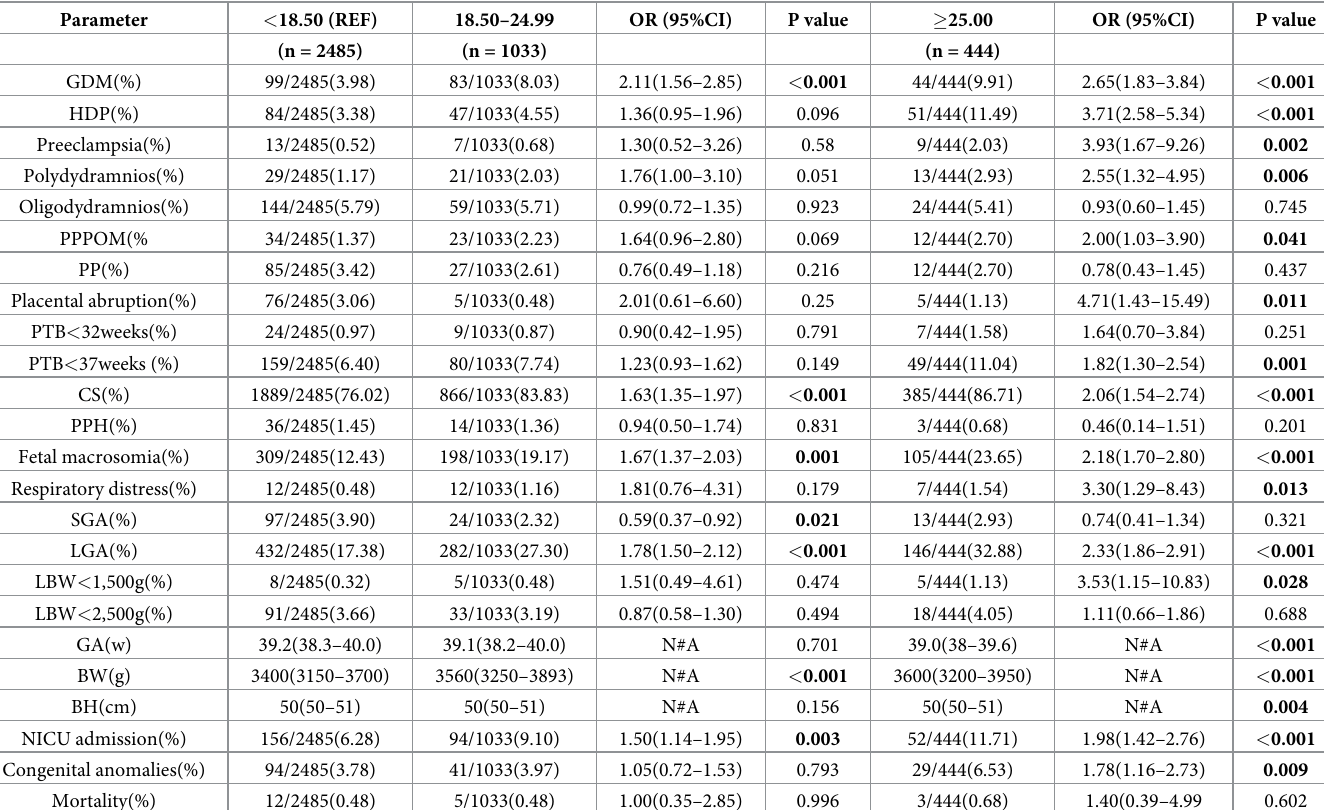
Table 2. Unadjusted association between BMI and adverse perinatal outcomes.